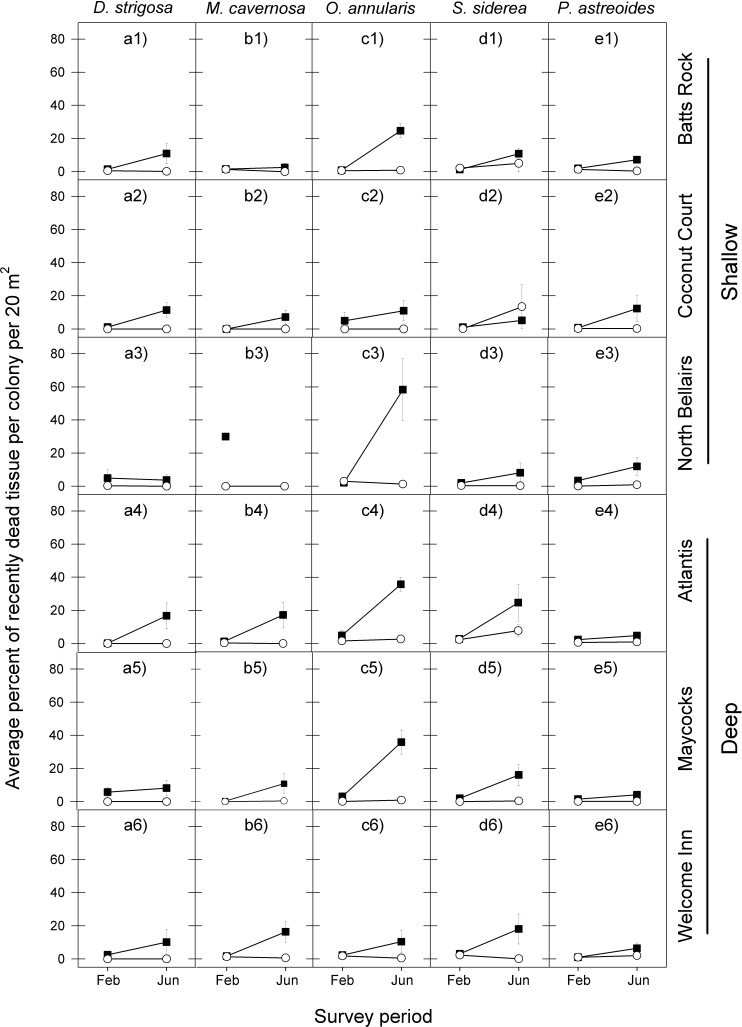
Average percent of recently dead coral tissue per colony during the post-bleaching survey periods (February and June) in 2006 (black squares) and 2011 (white circles) for the five selected dominant coral species (A–E) across the six study sites (1–6).Error bars denote 1 standard error. Missing symbol in b3 panel indicates that no M. cavernosa colonies were sampled at the North Bellairs site in June 2006.